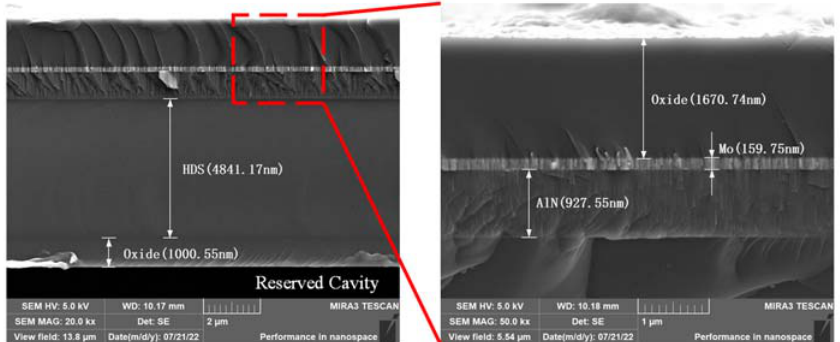
Figure 4. The front view diagram of ( a ) Type A and ( b ) Type B using an optical microscope.